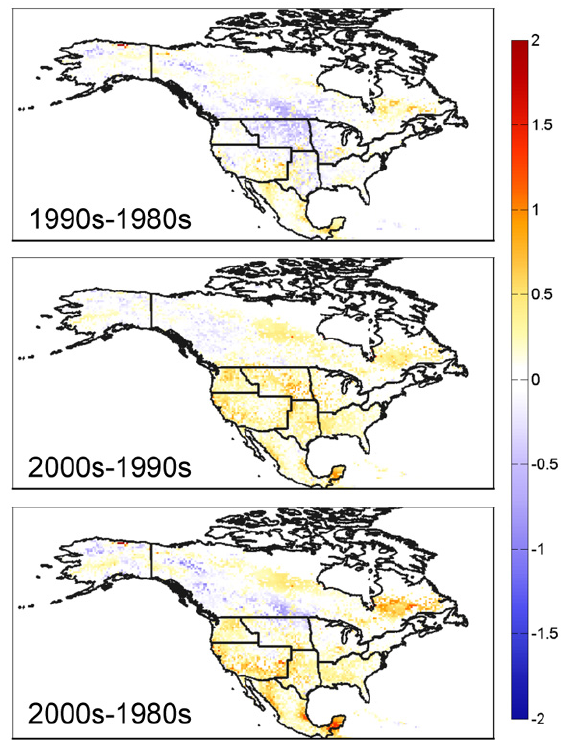
Fig. 12. Difference in decadal mean fire season PE for the 1980s, 1990s, and 2000s (mmday − 1 ). Cells without GFED BA area in any year (1997–2010) appear